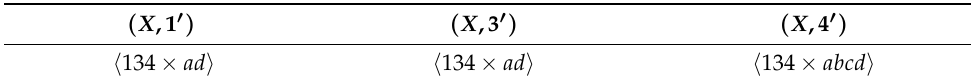
Table 13. Computing the object uniformity of C 2 .